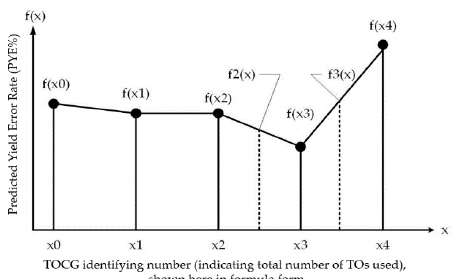
Figure 9. An abstract example of the Bisection Method in the trend graph for determining the optimum TOCG having minimum